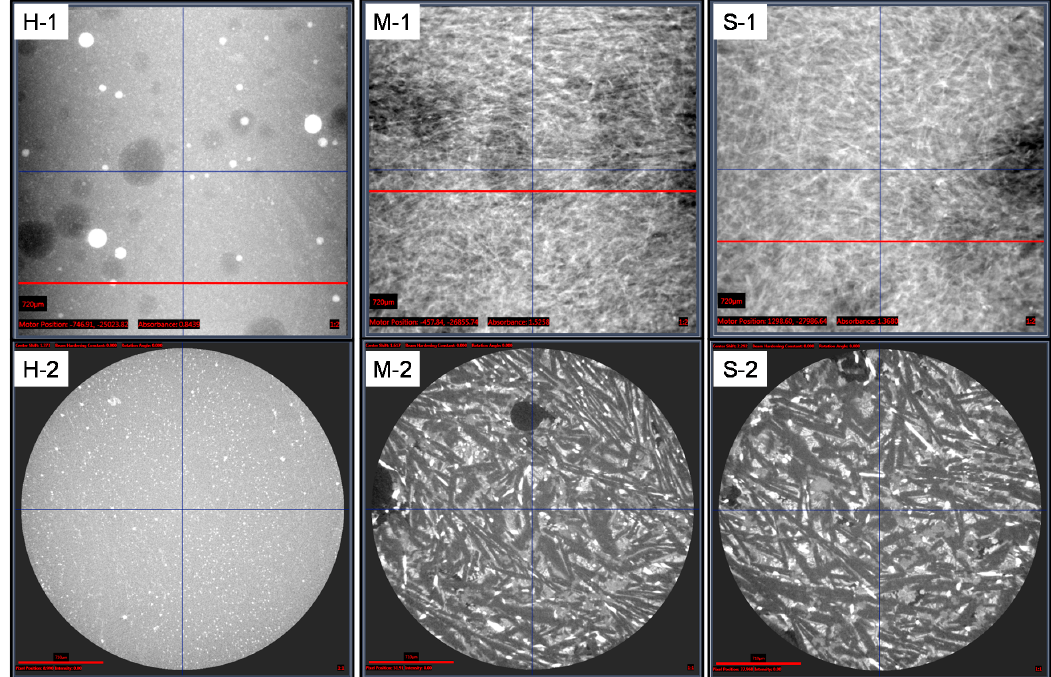
Figure 8. Results from XCT of samples H, M, and S. Top row: projection images of the analyzed volumes giving an overview of the structures and the size scale; bottom row: reconstructed cross-sections from the position of the red line in the projection images.